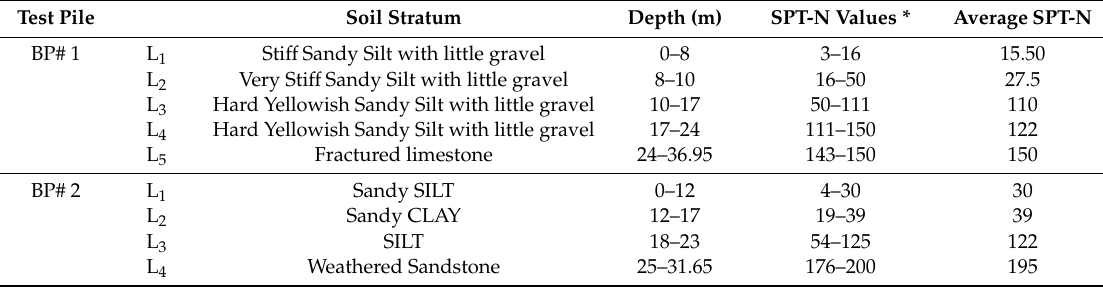
Table 2. Soil profile for tested bored pile after the standard penetration test (SPT).